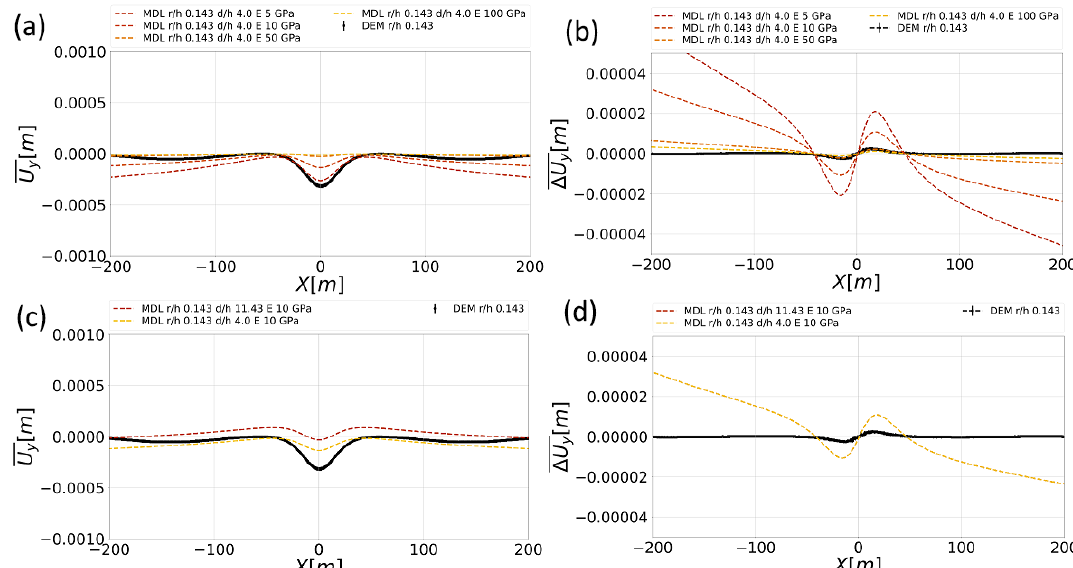
Figure B4. The effect of Young’s modulus E and fixed depth point d/h on the vertical displacement (a, c) and displacement difference (b, d) of the Mindlin (MDL) analytical solution as calculated by Verruijt and Booker (2009). Panels (a) and (b) show the scaling effect of the elastic modulus which affects both U y and (cid:49)U y . Panels (c) and (d) show the effect of d/h for E = 10GPa which shifts the U y curve but has no effect on (cid:49)U y